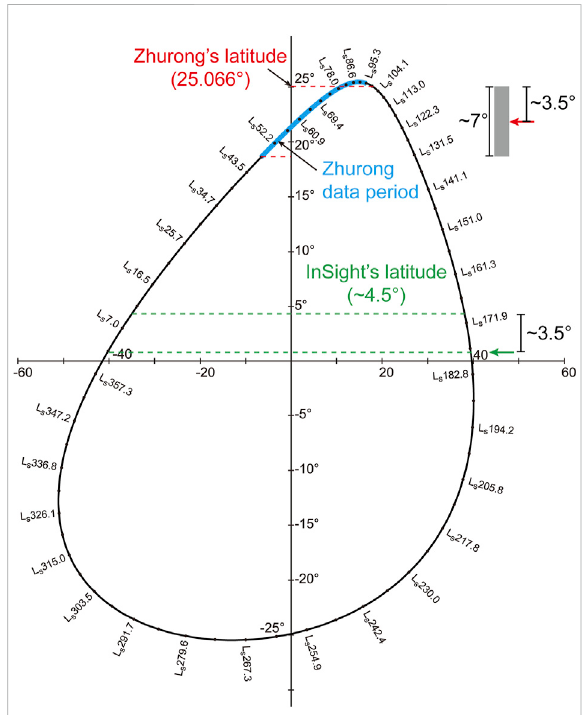
FIGURE 3 TheSolarlongitude(Ls)correctionfortherepresentativedaily temperature at Zhurong ’ s latitude according to InSight ’ s latitude. The horizontal axis is the equation of time (minutes) and the vertical axis is the declination (degrees). The Zhurong landing site (at the latitude of ~25 ° ) and InSight landing site (at the latitude of ~4.5) are marked, respectively. Zhurong temperature data period (Ls = 50 – 93, 72 ° on average) is marked as a thick blue line. ThedeclinationvariationfortheZhurongdataperiodis~7 ° .Forthe averageday(redarrow)oftheZhurongdataperiod,thereisa~3.5- degree declination/latitude difference to its hottest day. Accordingly, a ~3.5 ° declination/latitude difference is applied to the InSight landing site; thus, at the InSight landing site, the day with a similar daily temperature condition to the Zhurong landing site has an Ls of ~177 ° (green